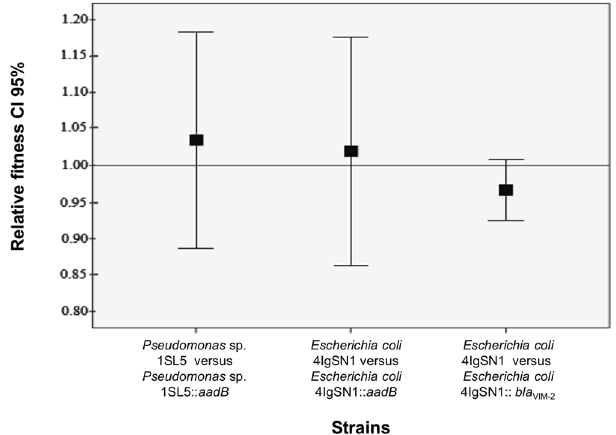
Figure 3. Pair-wise mixed culture competition experiments. Competence assays of environmental strains Pseudomonas sp. 1SL5 and E . coli 4IgSN1, against the corresponding ARGC ( aadB or bla VIM-2 ) inserted at the native attI1 site containing strain were conducted in order to determine the relative fitness. Error bars indicate 95% confidence intervals. By definition, a relative fitness (w) of 1.00 indicates no difference in relative fitness. Relative fitness values: Pseudomonas sp. 1SL5:: aadB W = 1.03 (0.88–1.18), E . coli 4IgSN1:: aadB W = 1.02